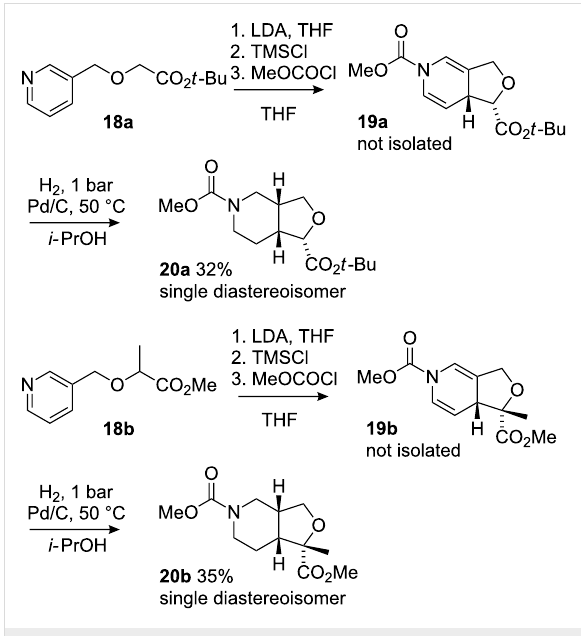
Figure 2: Determination of the stereochemistry of 20b . Arrows indi- cate nuclear Overhauser enhancements.